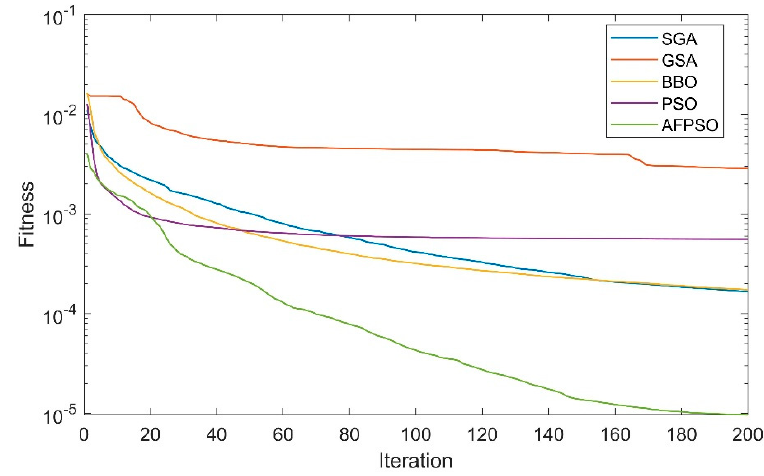
Figure 8. Average fitness change of the algorithms during parameter estimation (No-load condition).